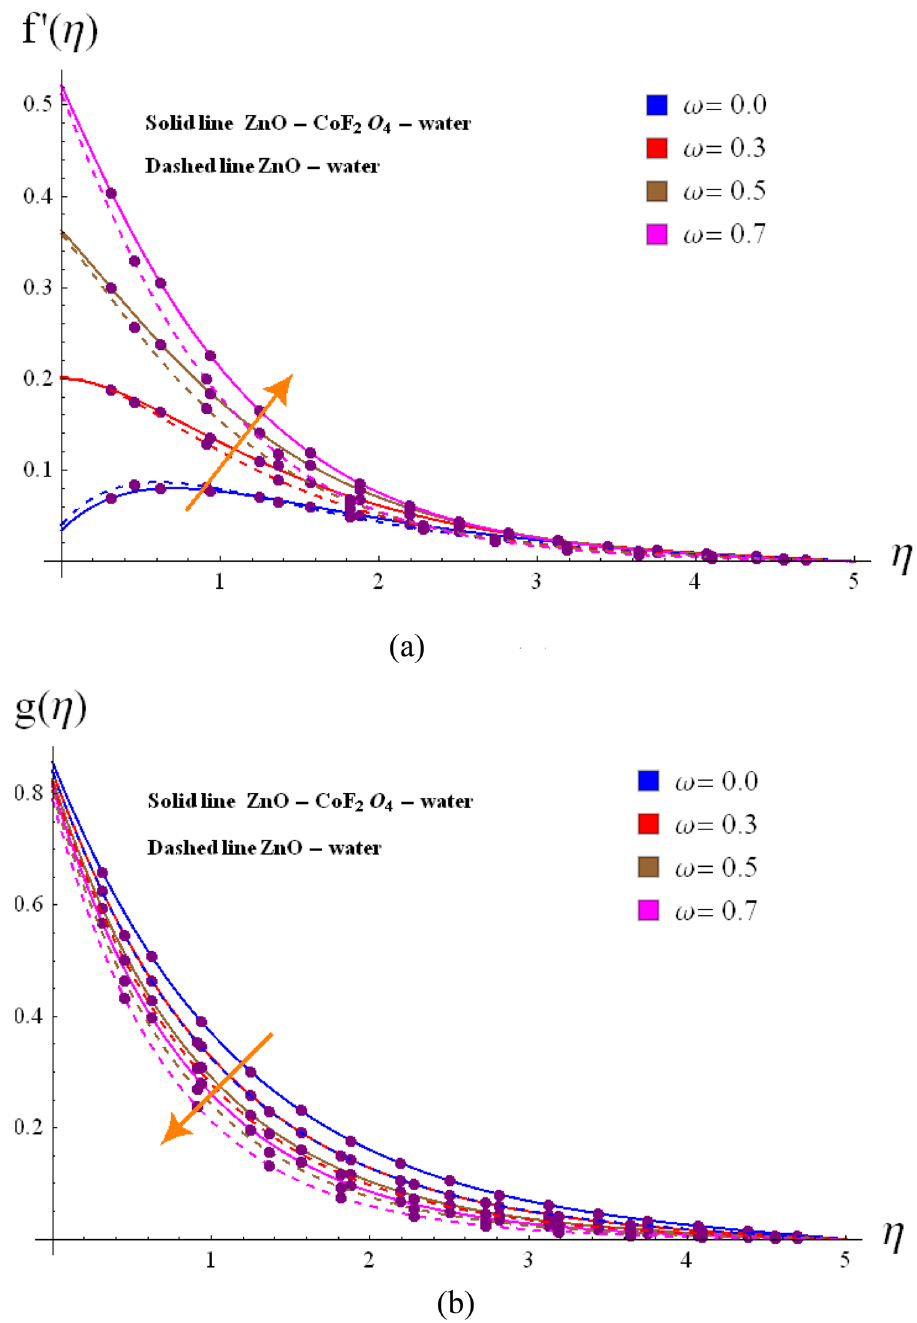
Figure 2. ( a ) Variation of f ′ (η) via ω . ( b ) Variation of g (η) via ω